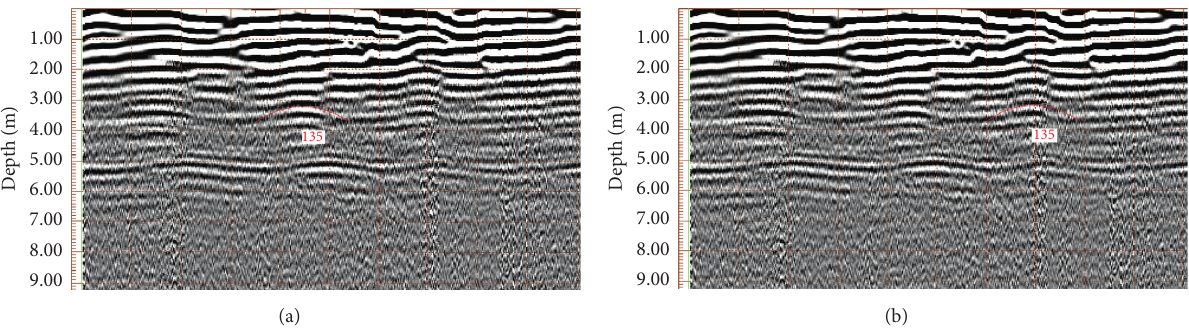
Figure 14: The results of the estimation of wave velocity. (a) First hyperbola match and (b) second hyperbola match.